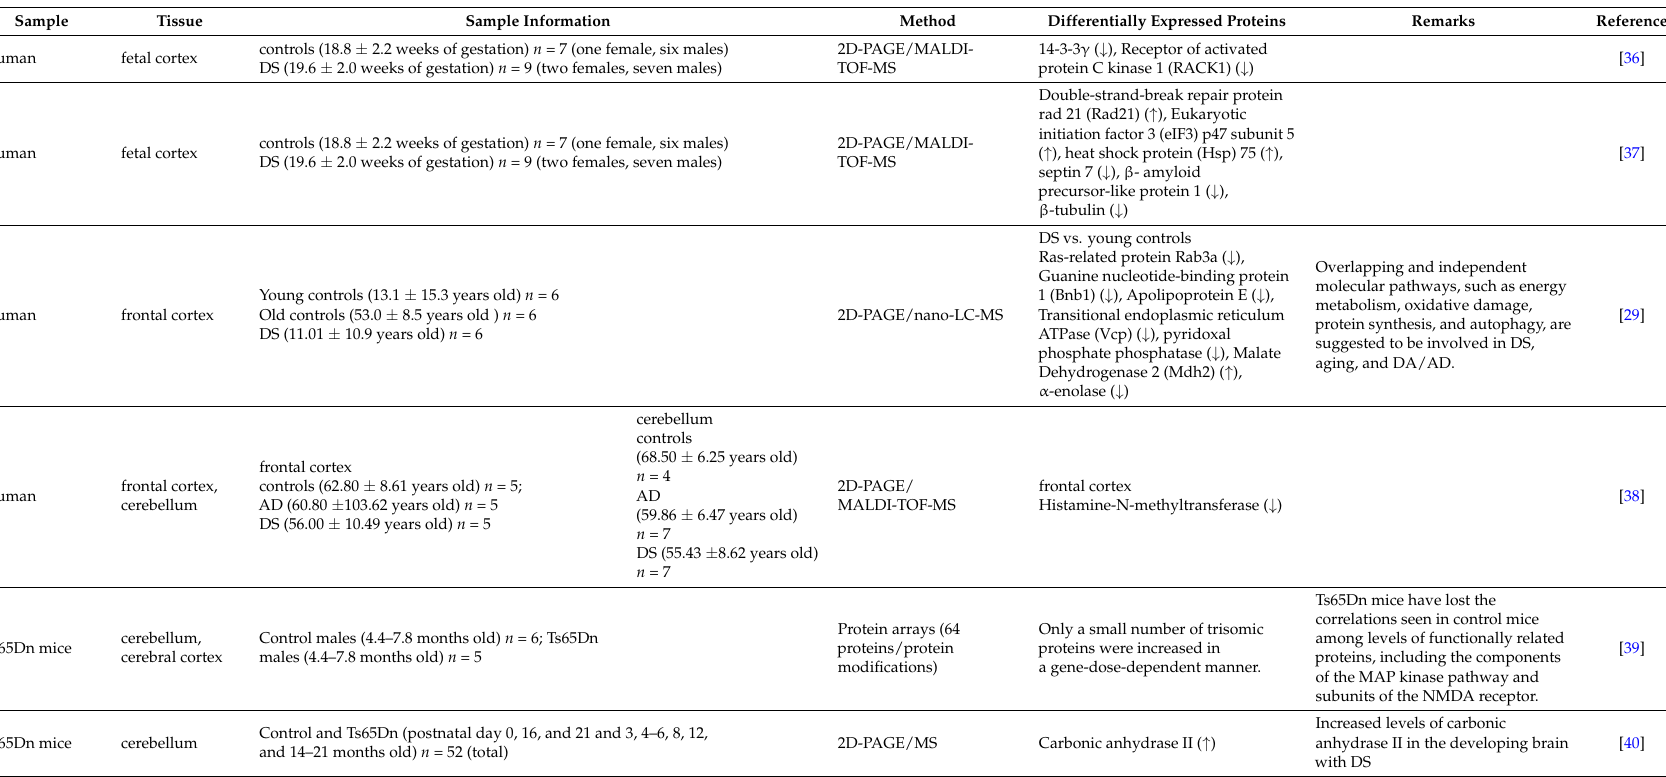
Table 2. A comparative proteomic analysis of the brain with